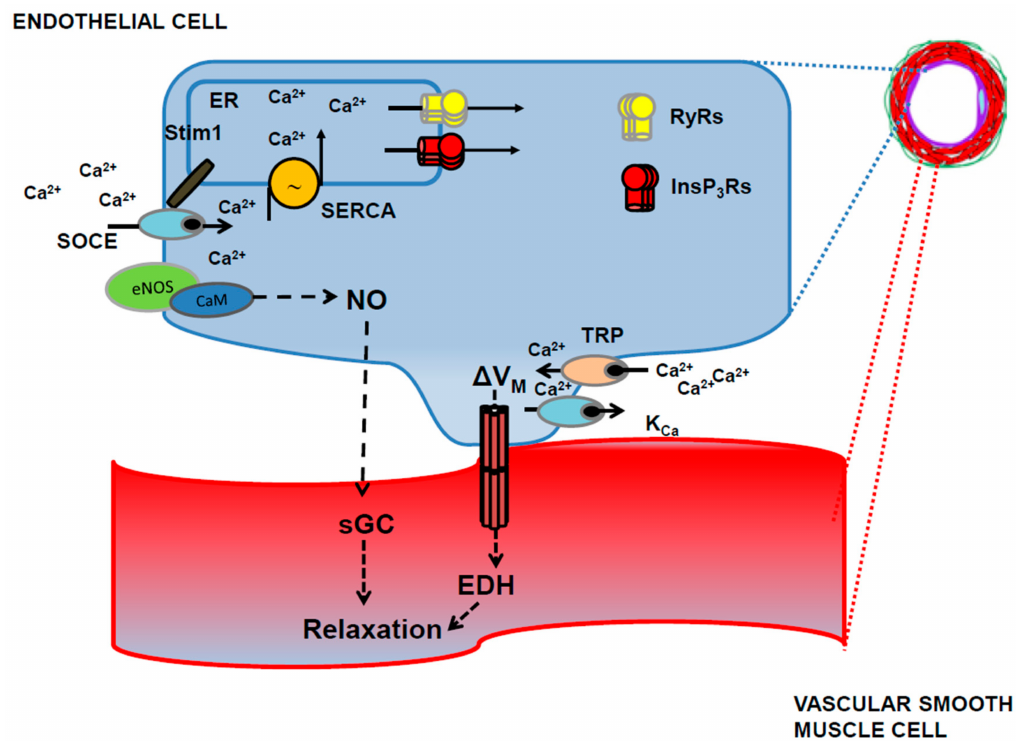
Figure 4. Ca 2+ -regulated endothelium-dependent vasodilation. Agonists-induced InsP 3 -dependent ER Ca 2+ depletion in vascular endothelial cells leads to store-operated Ca 2+ entry (SOCE). SOCE is tightly coupled to eNOS, thereby triggering robust NO release. NO, in turn, diffuses towards adjacent vascular smooth muscle cells (VSMCs) at myo-endothelial projections and activates soluble guanylyl cyclase (sGC) to induce vasorelaxation. Extracellular agonists may also activate TRP channels (e.g., TRPC3, TRPV3, TRPV4 and TRPA1), which is preferentially coupled to Ca 2+ -activated K + channels (K Ca ), such as IK Ca and SK Ca . Endothelial hyperpolarization spreads through myo-endothelial gap junctions to adjoining VSMCs to induce vasorelaxation according to a mechanism known endothelial-dependent hyperpolarization